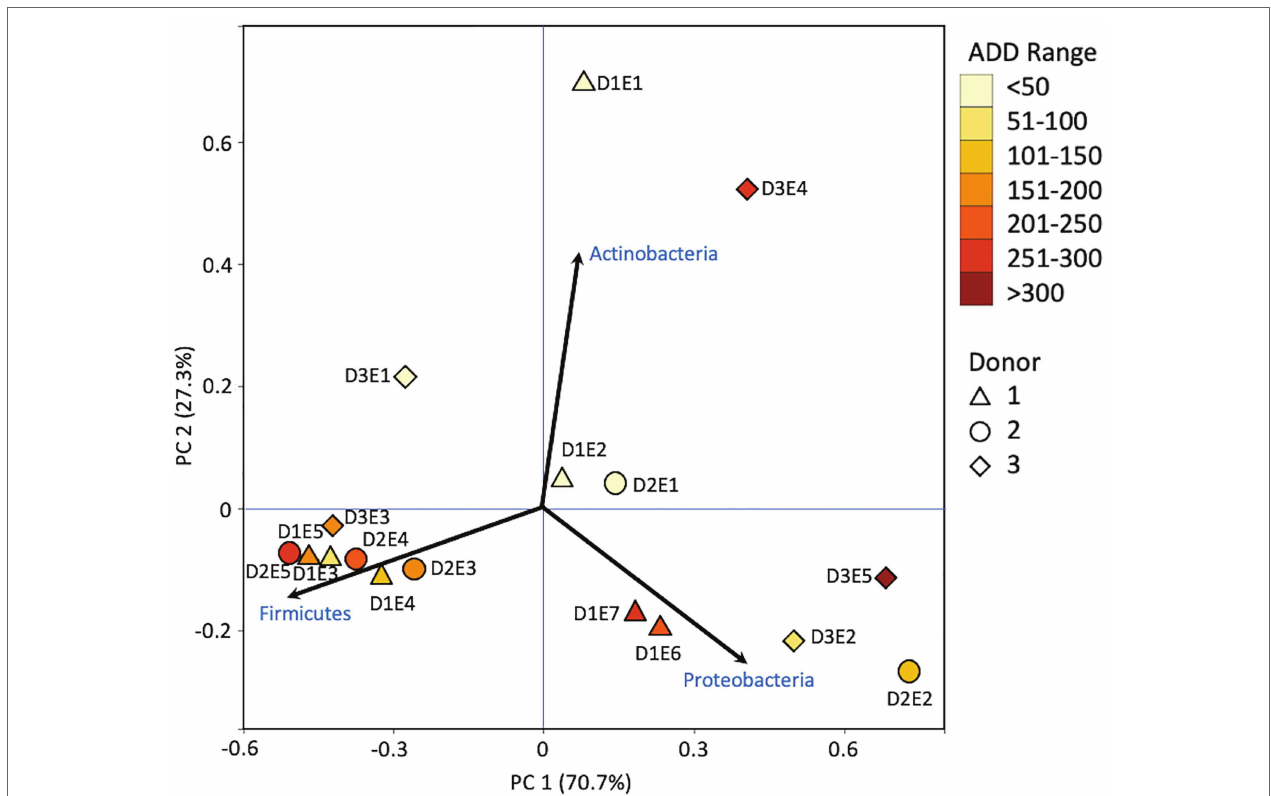
FIGURE 3 | Principal components analysis (PCA) plot for the proportional data of bacterial phyla observed from 16S rRNA gene sequencing of the V6–V8 hypervariable region from oral samples of three human donors (Donors 1, 2, and 3) during decomposition. Shading is added to the symbols [triangles for Donor 1 (D1), circles for Donor 2 (D2), and diamonds for Donor 3 (D3)] to show earlier (lighter shading) to later (darker shading) ADD and also times sampled (from E1 to E7 for D1 and E1 to E5 for D2 and D3, indicating first sample to last sample